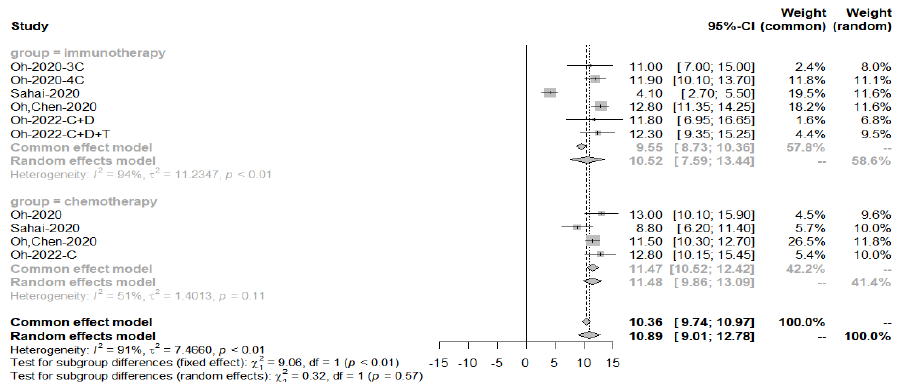
Figure 16. Progression ‐ free survival in the immuno ‐ chemotherapy combination group compared to the immunotherapy group.